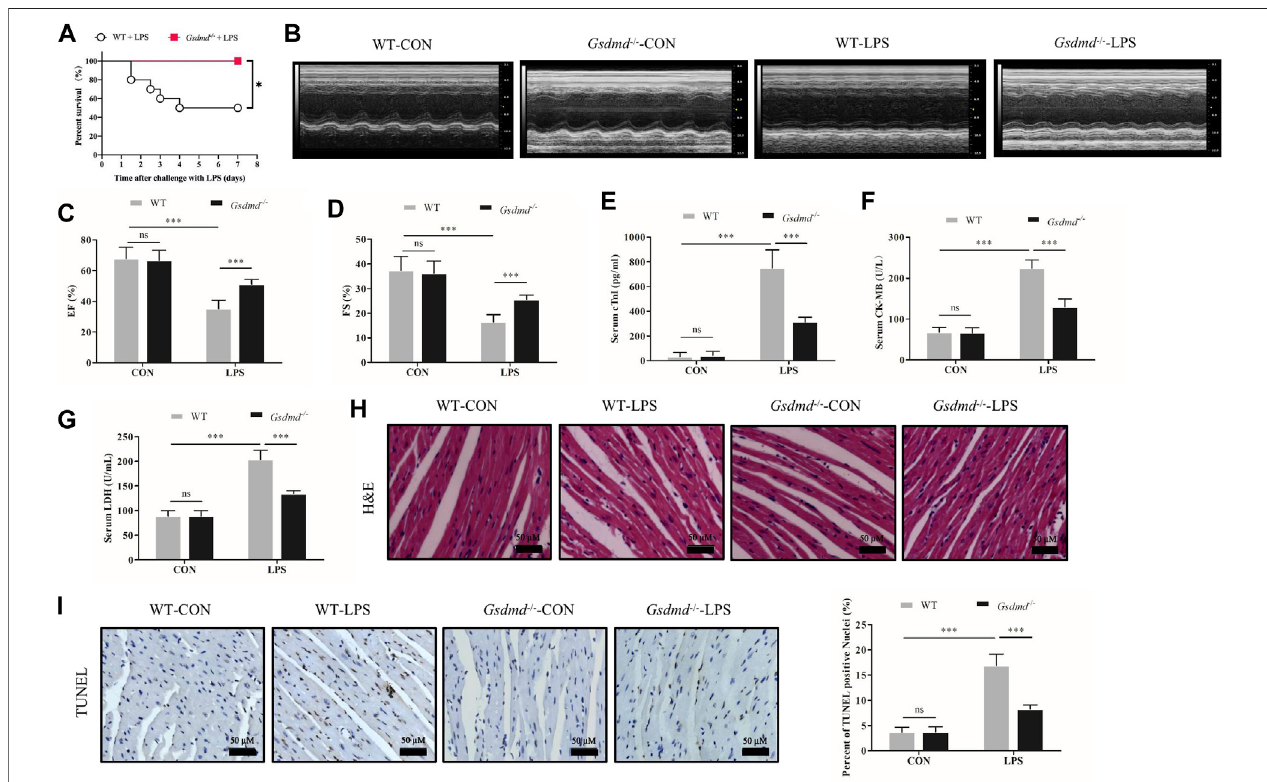
FIGURE 2 | Gsdmd de fi ciency improved the survival rate and attenuated myocardial injury and dysfunction in septic mice induced by LPS. (A) Survival rate of the WT-LPS groupand Gsdmd − / − -LPSgroup(n (cid:1) 10). (B) Representativeechocardiographyofmicefromeach group. (C,D) Myocardialfunctionparameters, EFandFSof micefrom each group were measured by echocardiography (n (cid:1) 8). (E – G) The levels ofcTnI, CK-MB, and LDH inserum from each group (n (cid:1) 8). (H) RepresentativeHE images of heart tissue from each group (magni fi cation × 400). (I) Representative TUNEL images of heart tissue from each group (magni fi cation × 400) and quantitative data of positive cells from randomly selected fi ve fi elds are shown on the right (n (cid:1) 5). Data are expressed as the mean ± SD. * p < 0.05, *** p < 0.001.